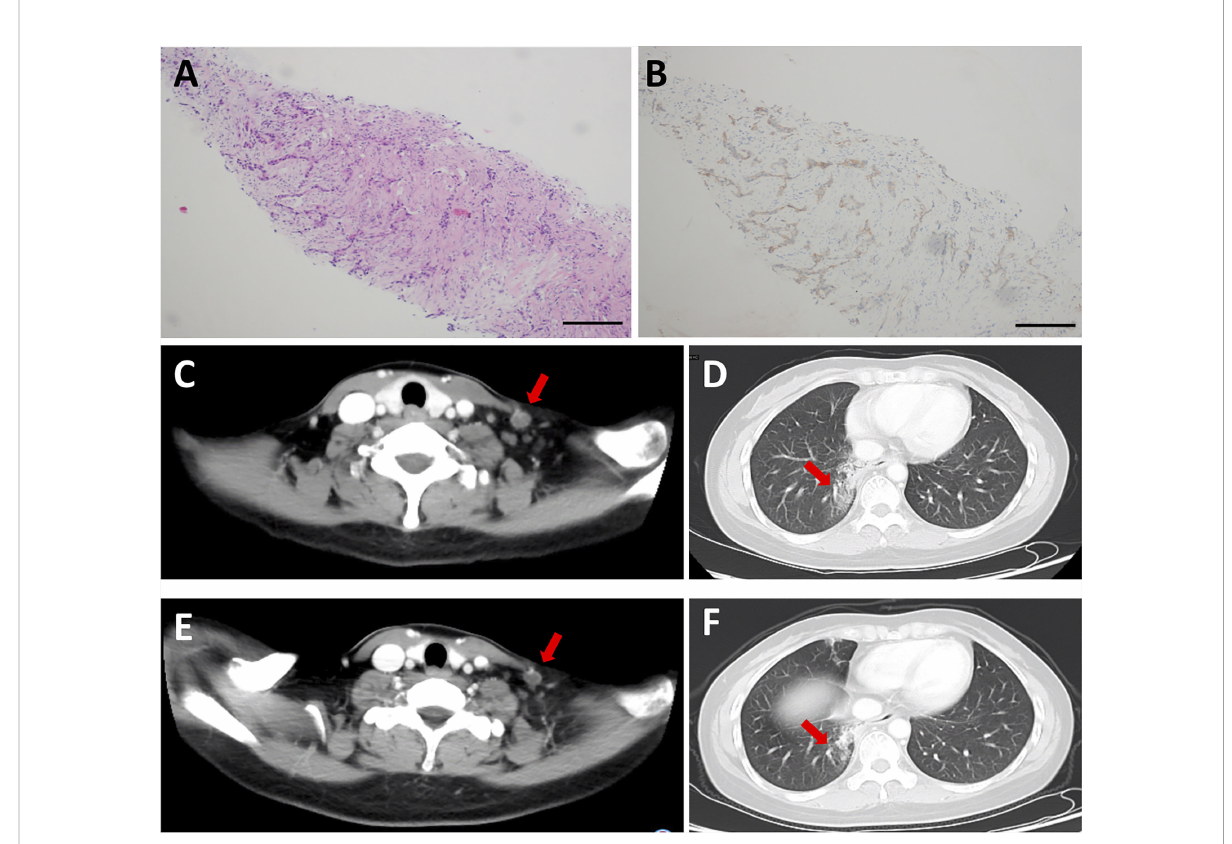
FIGURE 5 Representative H&E- and IHC-stained biopsy sections and CT images from a patient in the 60 mg CT053PTSA treatment group with advanced non-small cell lung cancer (EGFR, ALK negative) who achieved a durable stable response. (A) Representative H&E image of a stained biopsy from the left supraclavicular lymph node at baseline. (B) Representative IHC image of MET overexpression in a stained biopsy from the left supraclavicular lymph node at baseline. Baseline CT images (2014-11-24): (C) target lesion: left supraclavicular lymph node (red arrow) on enhanced CT. and (D) , nontarget lesion: lung metastases on enhanced CT. (E, F) , Cycle 2 Day 28 CT image (2015-02-04): target lesion and nontarget lesion at stable